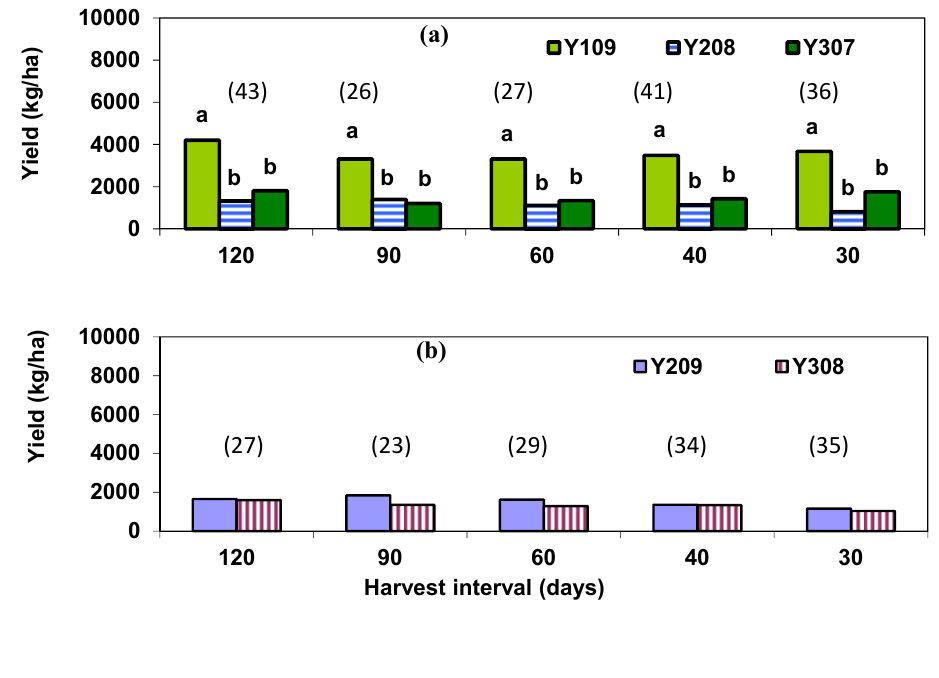
Figure 2. Post-season recovery yield of ( a ) first-, second- and third-year plots on 21 May 2009 and ( b ) second- and third-year plots on 25 May 2010. Above each group of bars, numbers in brackets are the coefficients of variation due to harvest duration within respective harvest intervals. Bars bearing different uppercase letters indicate significant yield differences at α =